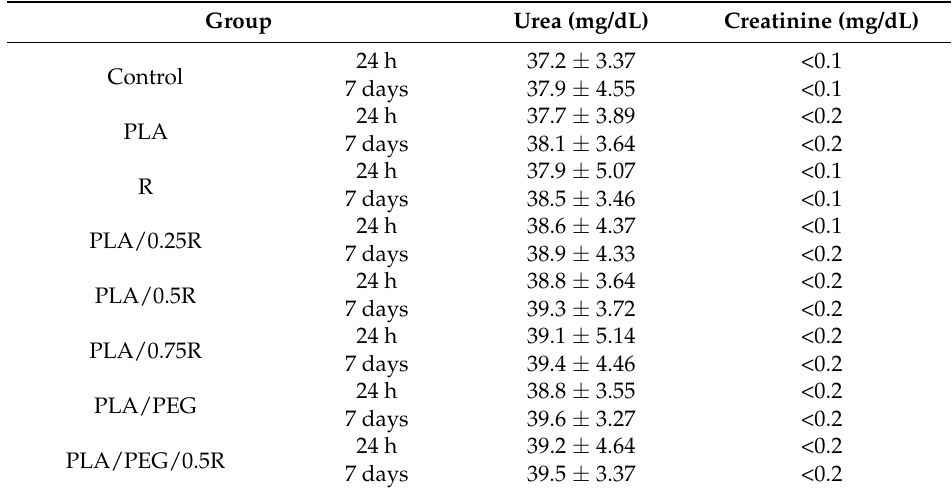
Table 14. The effects of PLA-based materials containing rosemary ethanolic extract on the serum urea and creatinine concentration. Values were expressed as mean ± S.D. for six rats in a